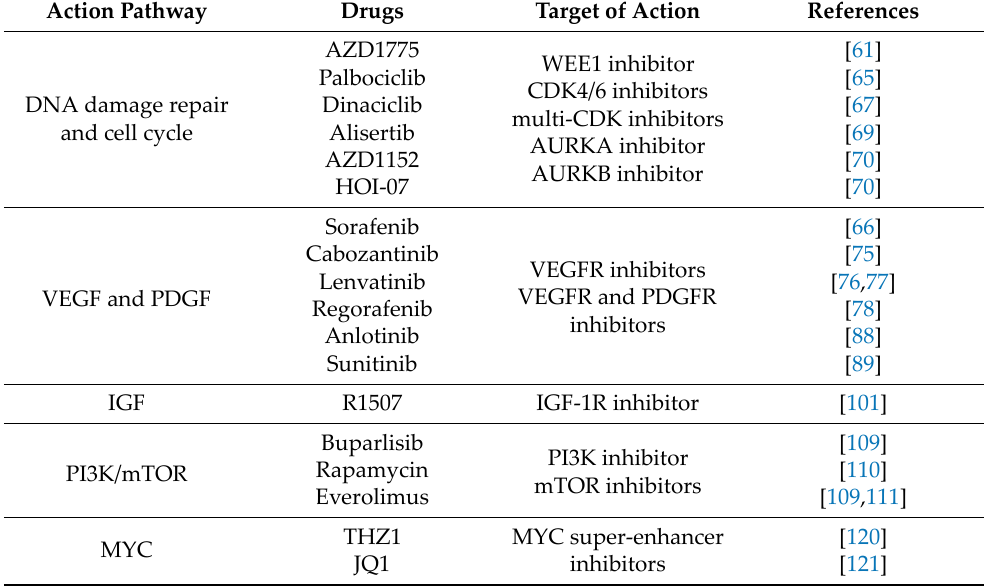
Table 3. Drugs for each targeted pathway associated with osteosarcoma and their therapeutic